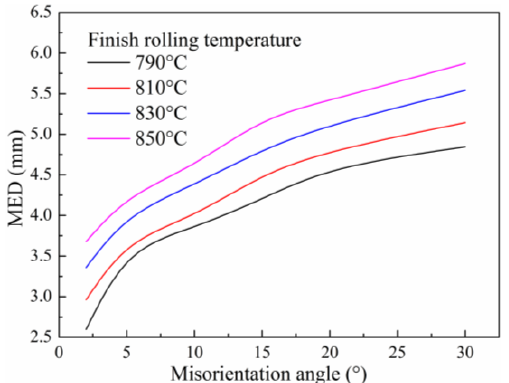
Figure 10. The EBSD mean effective size of ferrite matrix, as a function of the misorientation angle and finish rolling temperature. MED—mean equivalent diameter.